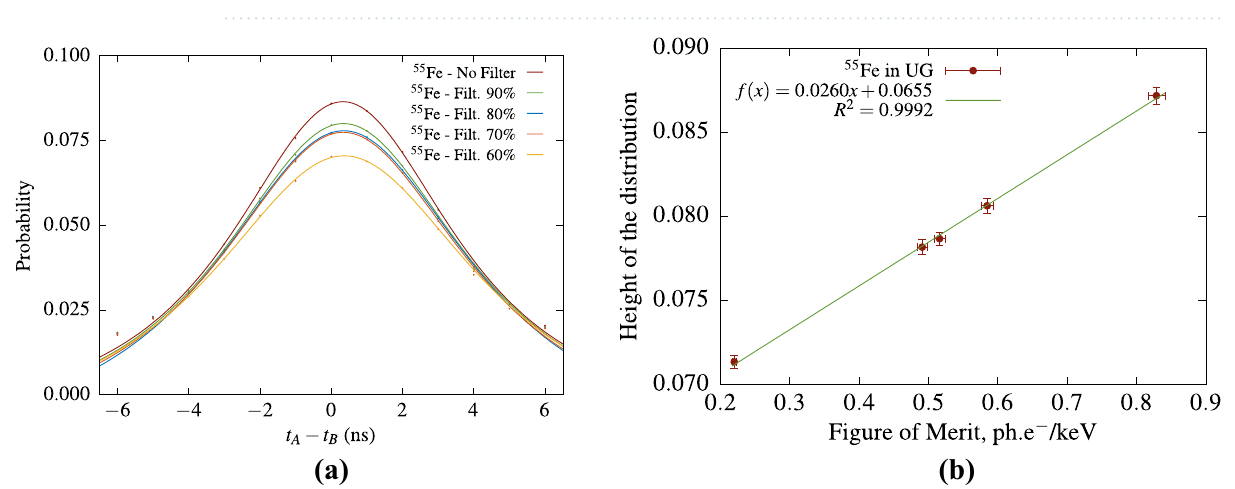
55 Fe in Ultima Gold cocktail and various levels of grey filters. The